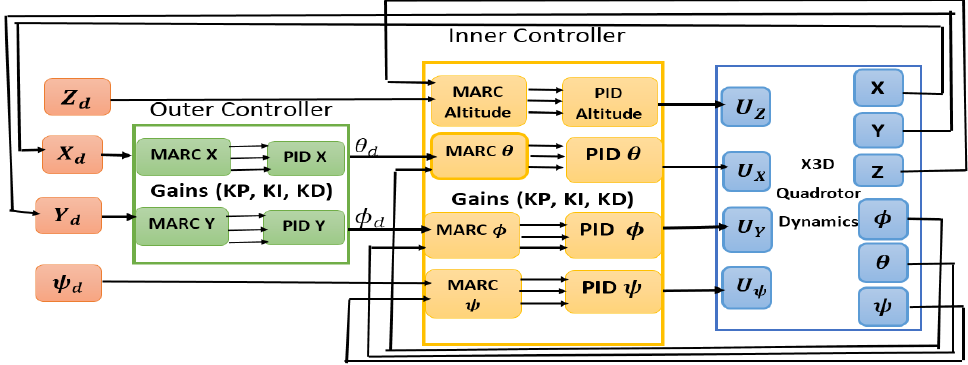
Figure 11. MRAC Adaptive PID Controller with MIT for an X3D Quadrotor.